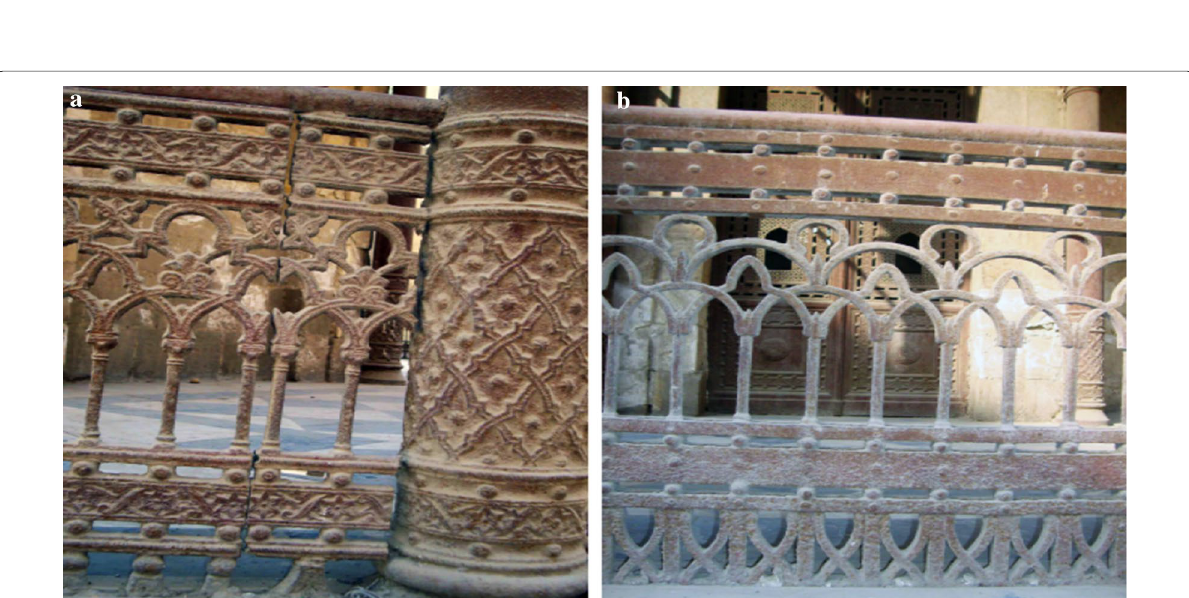
Fig. 4 Dust particles covered the fine details of the decorative iron